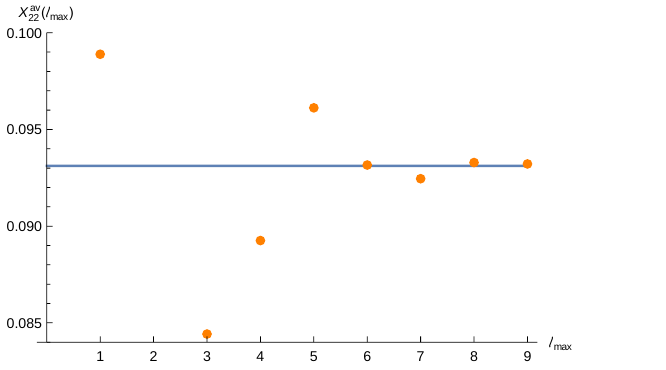
( ‘ max ) in the range [0 : 268 ; 0 : 320] plotted against ‘ max . Blue 22 . 22